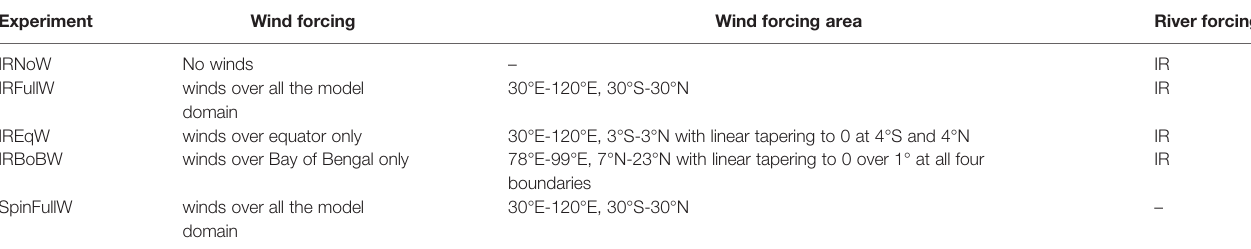
TABLE 1 | Details of river and wind forcing for different experiments.